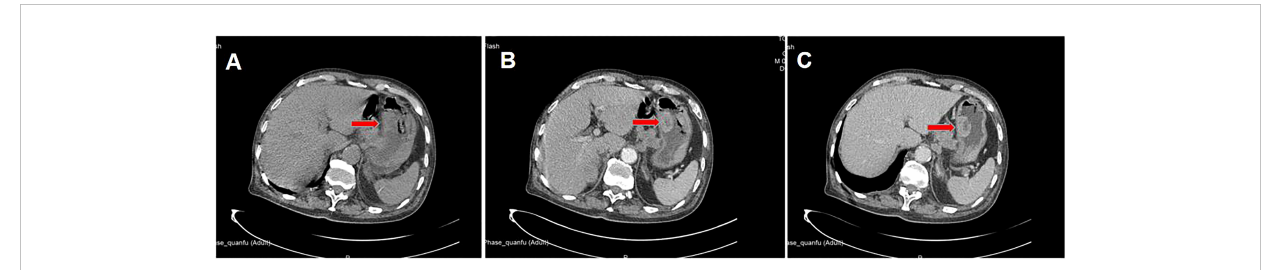
FIGURE 4 Location of the stomach tumor in abdominal enhanced CT. (A) Plain scan; (B) arterial phase; (C) venous phase.